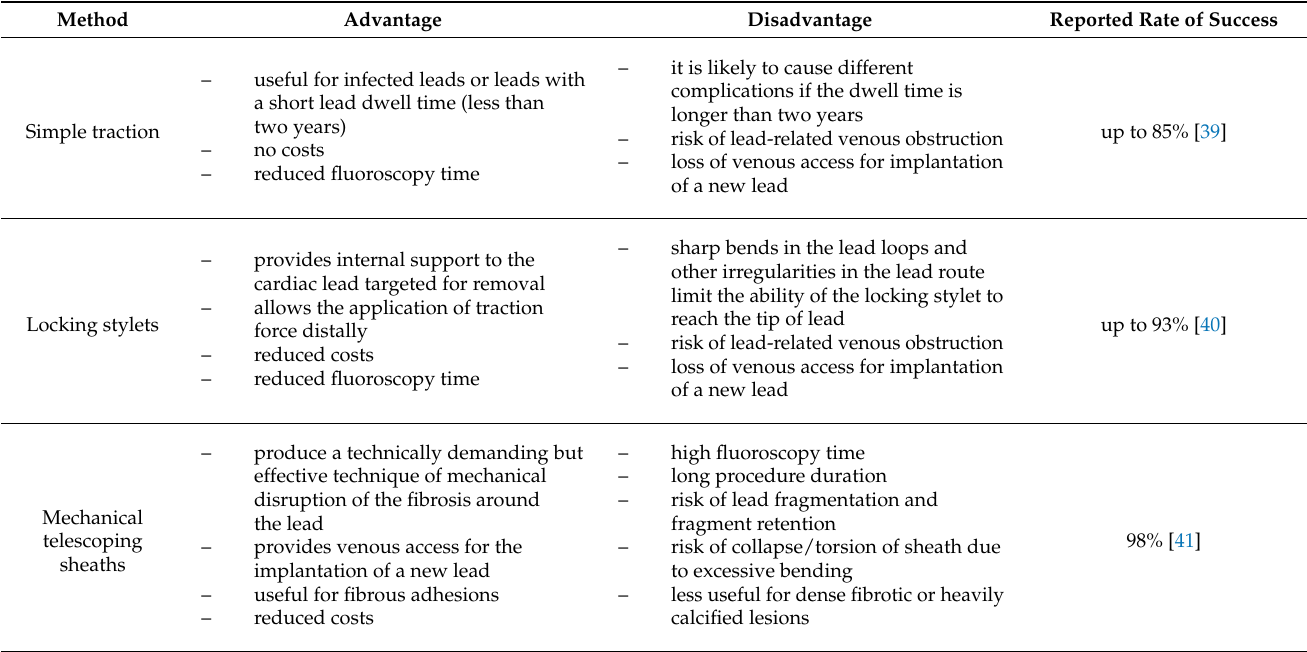
Table 1. Advantages, disadvantages, and reported rate of success for different TLE